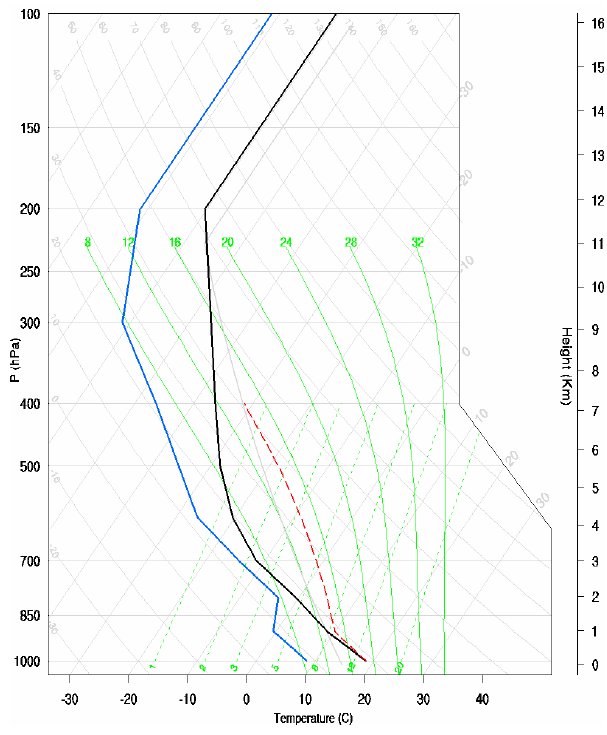
Fig. 1. Initial conditions for the thermodynamic profile of the